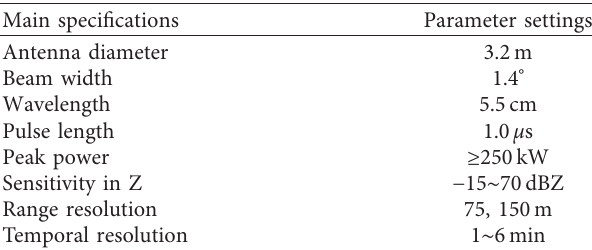
Figure 1: (a) Distribution of 15 S-band operational Doppler radars (circles), and the campaign field site of Xianning station (red dot), as well as Yangtze River (thick solid lines) and boundaries of provinces (thin solid lines); shadings represent the terrain height. Hubei Province is indicated by the blue line. (b) Simulation domain used in the WRF simulations; the black box represents the range of Figure 1(a) for domain- average analysis in this study. Table 1: Main specifications of the C-POL used in the IMFRE field